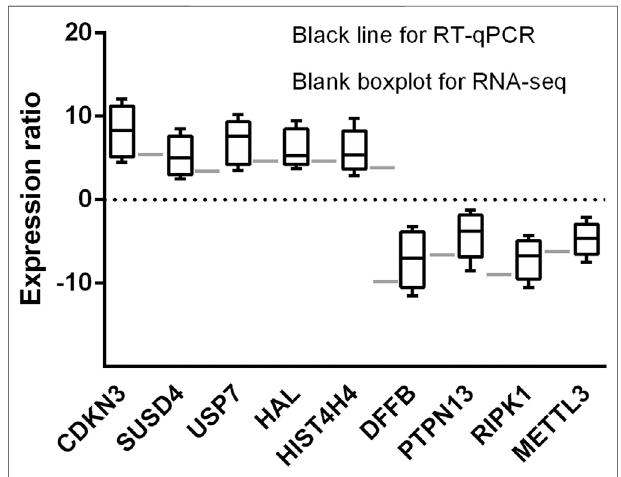
FIGURE 8 | Histogram indicates the expression change of the nine selected genes detected by RT-qPCR (black bars, n (cid:1) 6) and scRNA-seq (whitebars, n (cid:1) 3).TheresultsshowingthescRNA-seqanalysisandRT-qPCR were consistent with expression change of the nine identi fi ed genes.